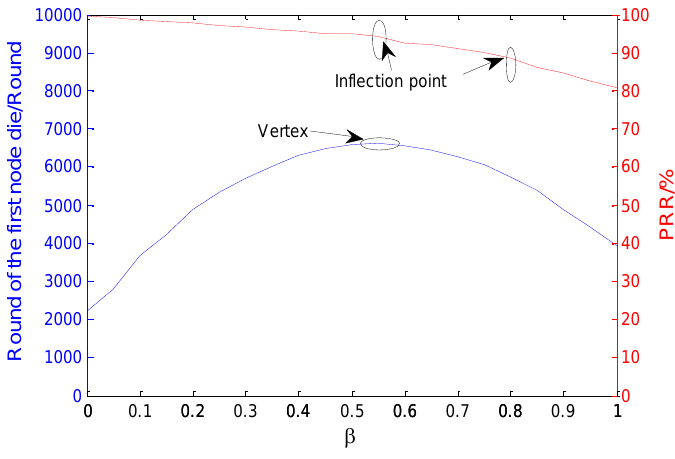
Figure 8. Impact of β on network performance.